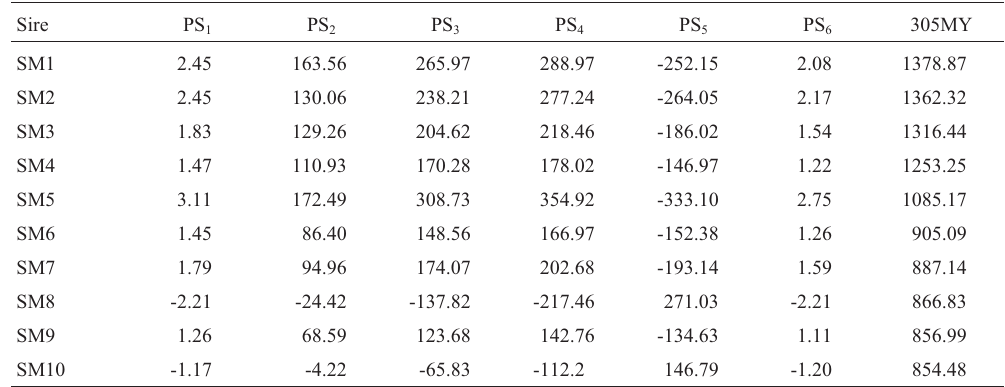
Table 3 - Estimated breeding values for different measures of persistency of lactation (PS 1 to PS 6 ) and 305-day milk yield (305MY) for the top ten sires with more than 25 daughters ranked for milk yield. Sire